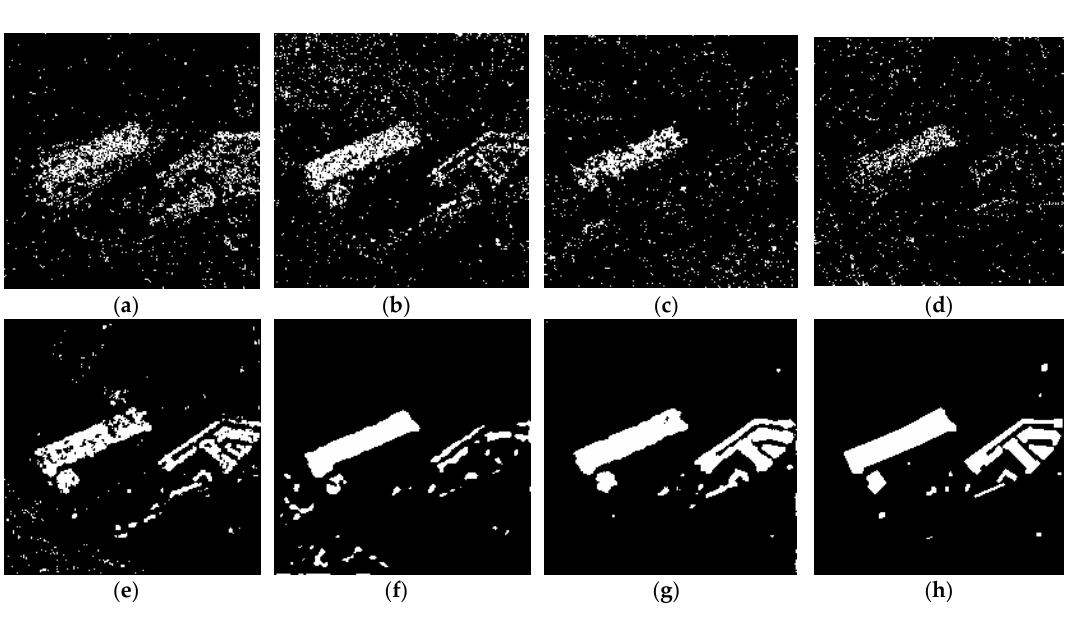
Figure 21. The change detection maps of different methods for the PolSAR-San Francisco1 dataset. ( a ) CVA-SVM, ( b ) MAD-SVM, ( c ) PCA-SVM, ( d ) IR-MAD -SVM, ( e ) SFA-SVM, ( f ) 3D-CNN, ( g ) Proposed Method, and ( h ) Ground Truth. White and black colors indicate the change and no-change areas, respectively.